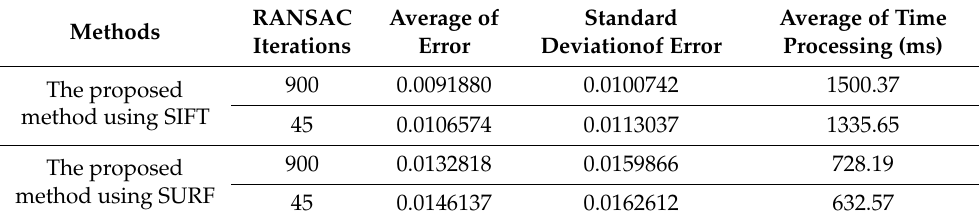
Table 3. The performances of the proposed method with reduction of type 2 and type 3 using scale-invariant feature transform (SIFT) and speeded-up robust features (SURF)